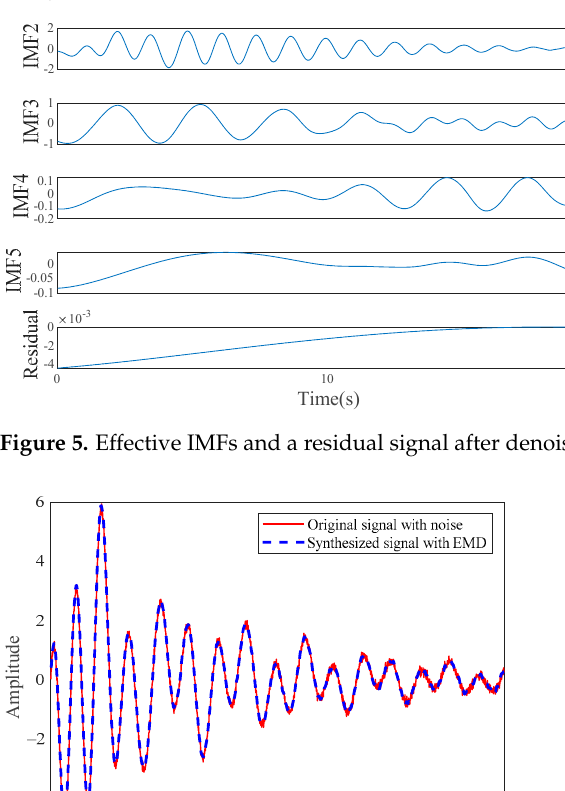
Figure 6. Comparison of the synthesized signal by EMD with signal A.